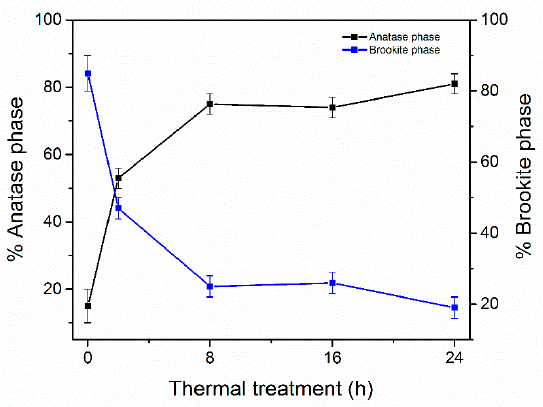
Figure 3. Percentage of anatase and brookite in the prepared samples estimated by quantitative phase analysis of XRD patterns as a function of thermal treatment duration in an oven at 110 °C.